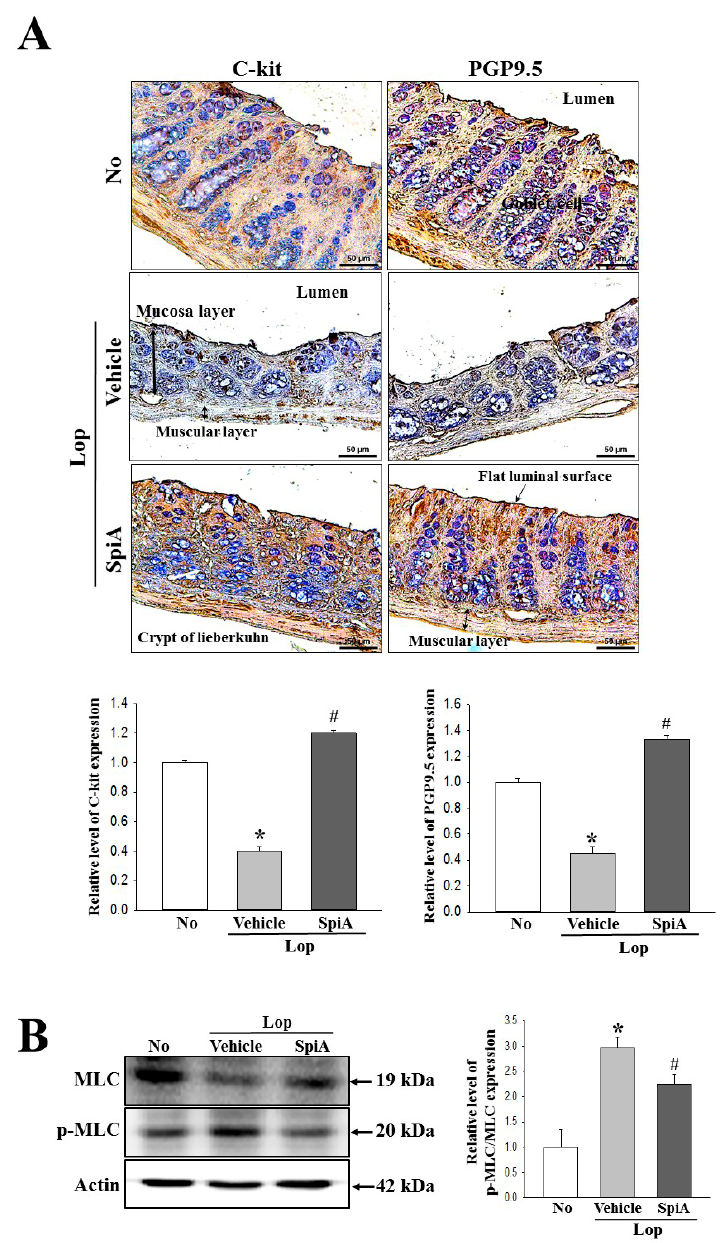
Figure 7. Expression of c-Kit and PGP9.5 and phosphorylation of MLC in neural, Cajal and smooth muscle cells. ( A ) Following staining with c-Kit and PGP9.5 antibody, their levels around the mucosa were observed in colon tissue at 400 × magnification. Five to six mice per group were used in preparation of colon tissue slide and expression level was assayed in duplicate in each test. ( B ) Expression of MLC and p-MLC measured using western blot analyses with an HRP-labeled secondary anti-rabbit IgG antibody, and the relative levels of each protein was calculated relative to the intensity of actin bands. Five-to-six mice per group were used in preparation of total lysate and specific protein level was assayed in duplicate in each test. Data are reported as the mean ± SD. *, p < 0.05 compared to the not-treated group. # , p < 0.05 compared to the Lop + Vehicle treated group. No, Untreated group; Lop, Loperamide; SpiA, Spicatoside A, MLC; Myosin light chains.